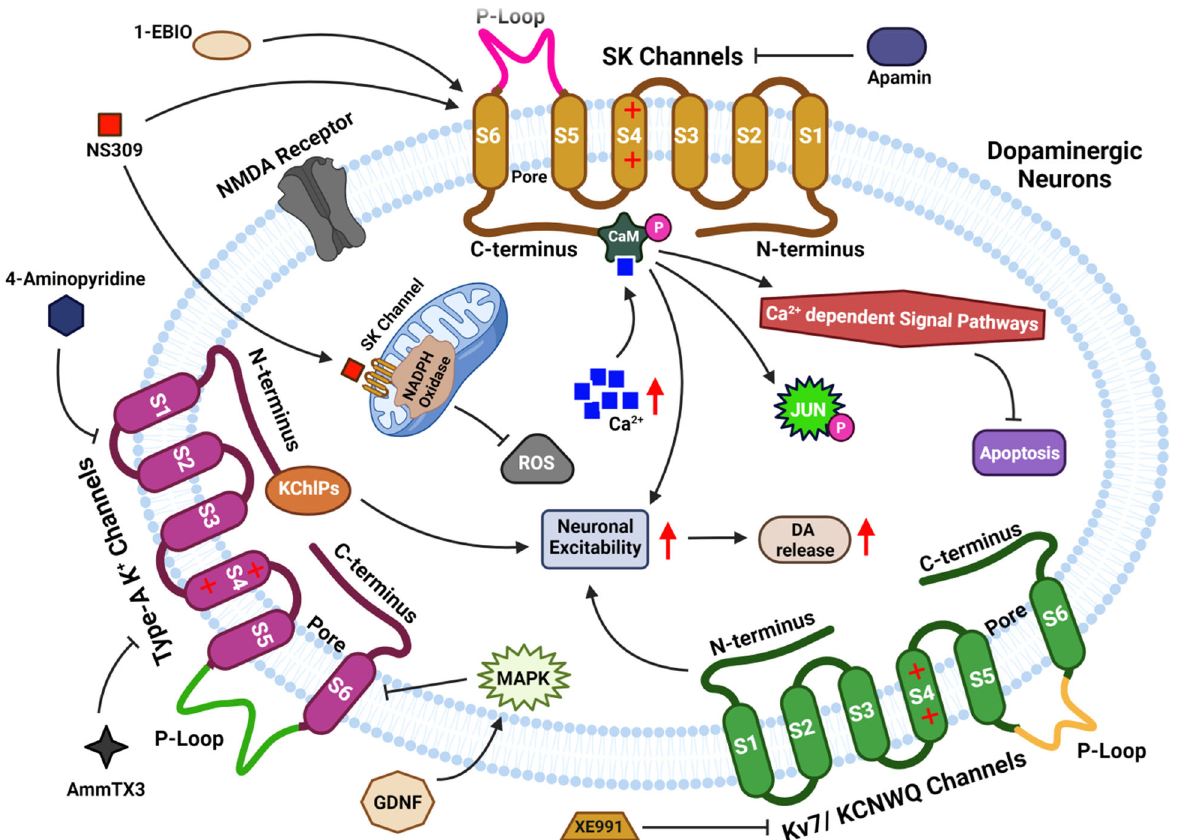
Fig. 9 Mechanistic view of roles of different K + -channels in the diagnosis and treatment of the PD pathogenesis. Cellular and animal models of Parkinsonism showed that SK channels, Type-A K + channels, and Kv-7/ KCNQ channels possess a potential for PD diagnosis. Activators and blockers of these three potassium channels protect the dopaminergic nerve cells in SNc, modulate excitation of nerve cells, in fl uence the release of DA, and attenuate motor symptoms. NMDA N-methyl-D-aspartate receptor, NADPH Nicotinamide adenine dinucleotide phosphate oxidase, MAPK Mitogen-Activated Protein Kinase pathway, GDNF Glial-cell derived neurotrophic